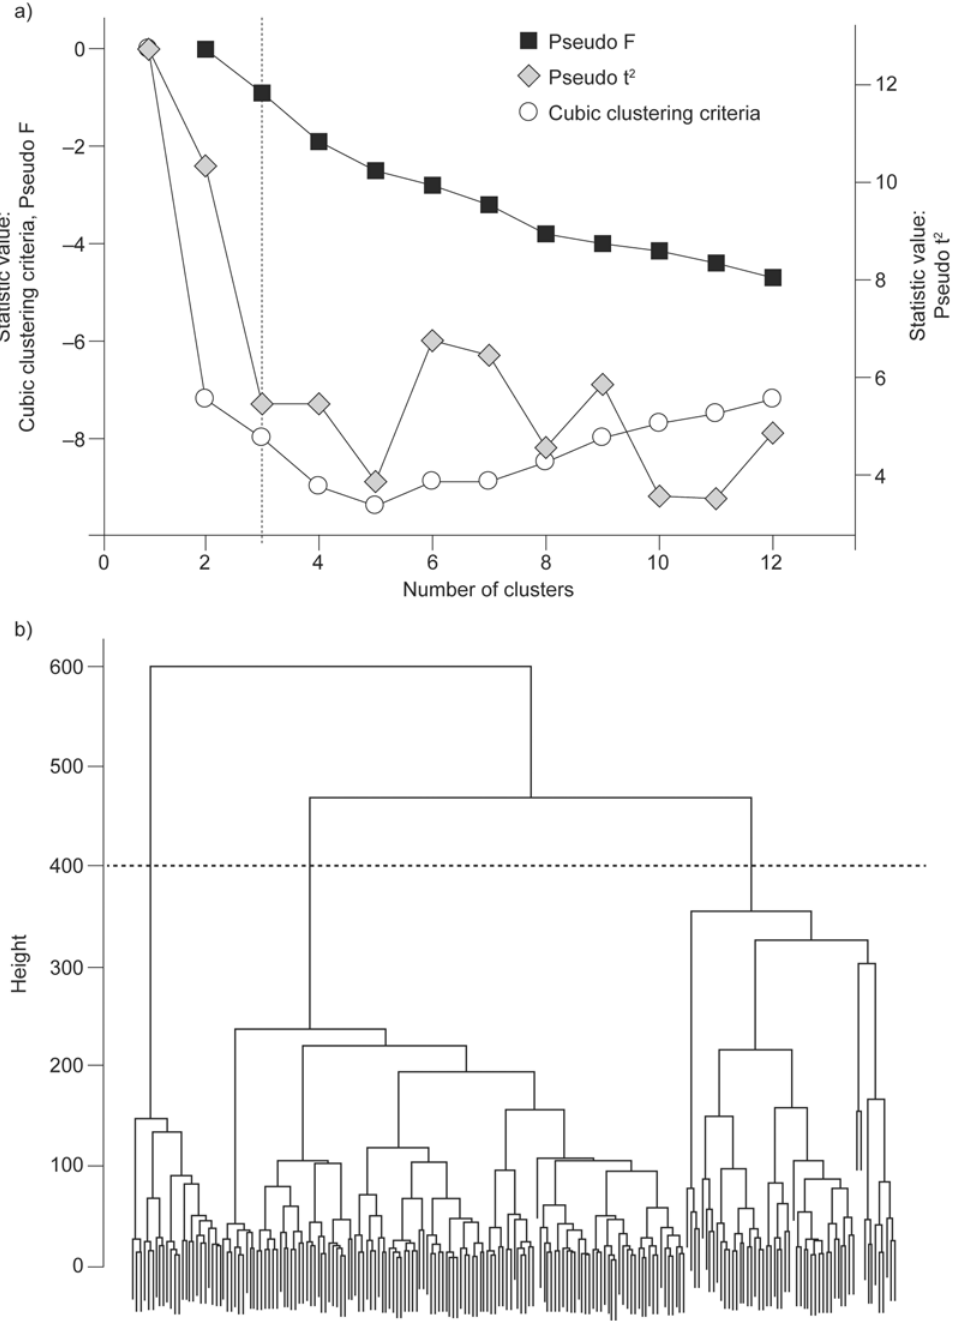
Fig 2. Determination of the number of clusters. a) Using three statistics (the statistical value of pseudo F statistic and cubic clustering criterion are reported on the left Y axis while the statistical value for pseudo t 2 statistic is reported on the right Y axis) and b) hierarchical Ward ’ s clustering